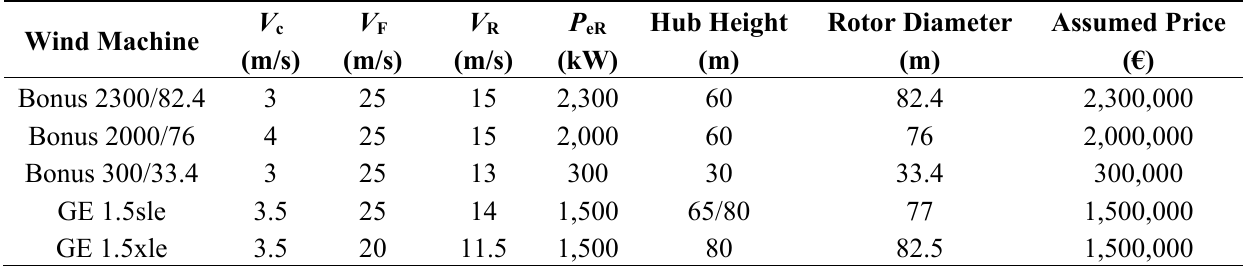
Table 3. Technical parameters of wind turbine models used in the analysis